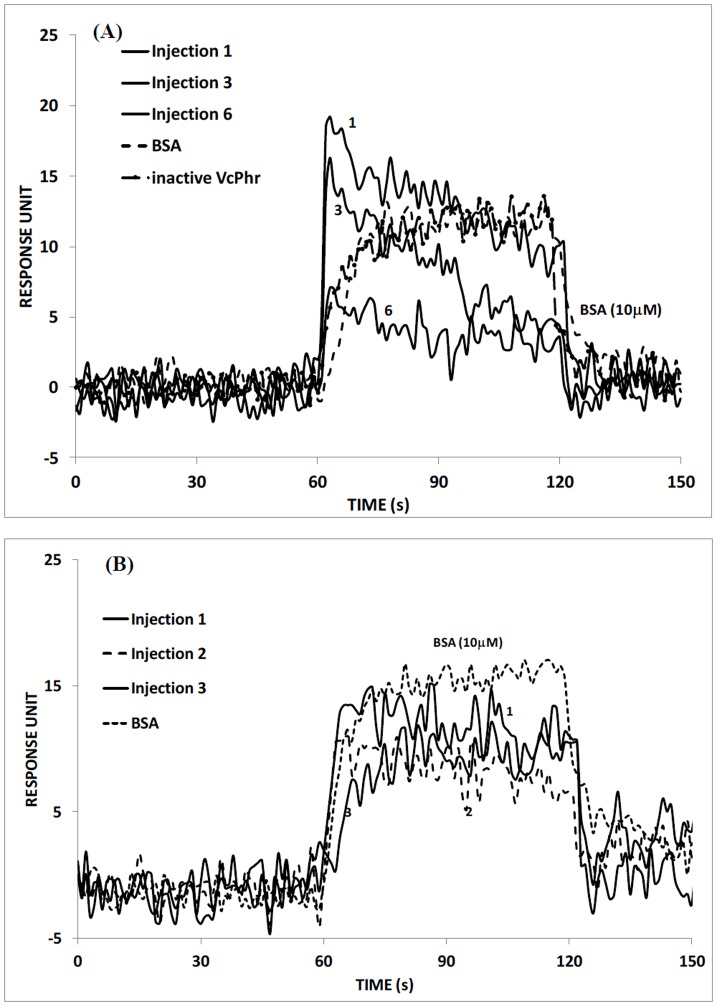
(A) Sequential injection of VcPHR on UV-damaged ssDNA, and injection of inactive VcPHR on UV-damaged ssDNA.(Injection concentration of 1 µM was used for inactive VcPHR.) (B) UV-damaged dsDNA bound surfaces where the concentration of VcPHR was kept constant at 10 nM for all injections. Data are mean ±1.6 RU for 3 independent experiments. Response units are statistically significant with p<0.05.